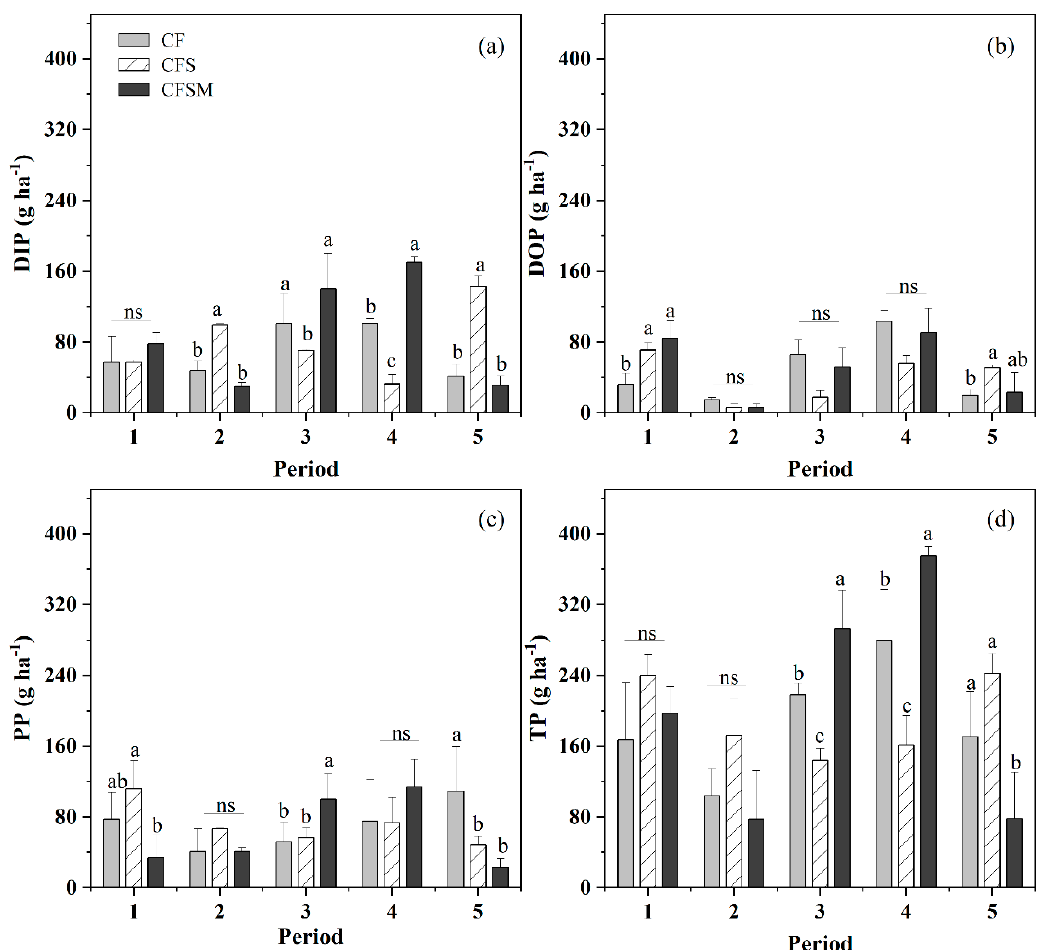
Figure 3. Seasonal variations in leaching losses of DIP ( a ), DOP ( b ), PP ( c ), and TP ( d ). Error bars represent standard deviations. Different lowercase letters on each sample date indicate significant differences among different treatments at p = 0.05, and ns mean no differences among the